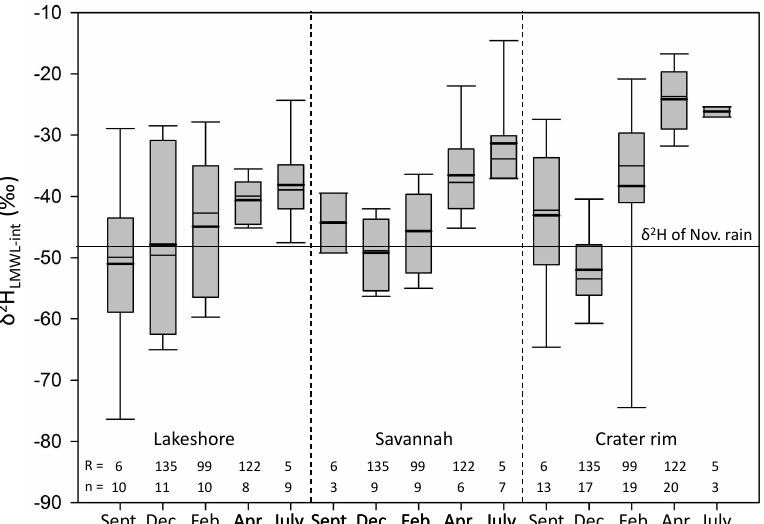
Figure 4. The average isotopic signature of the source of xylem water ( δ 2 H LMWL-int ) , determined from the intersection of xylem water samples with the LMWL, among habitats and seasons. Nov.: November; n : amount of samples; R : rainfall amount (mm).